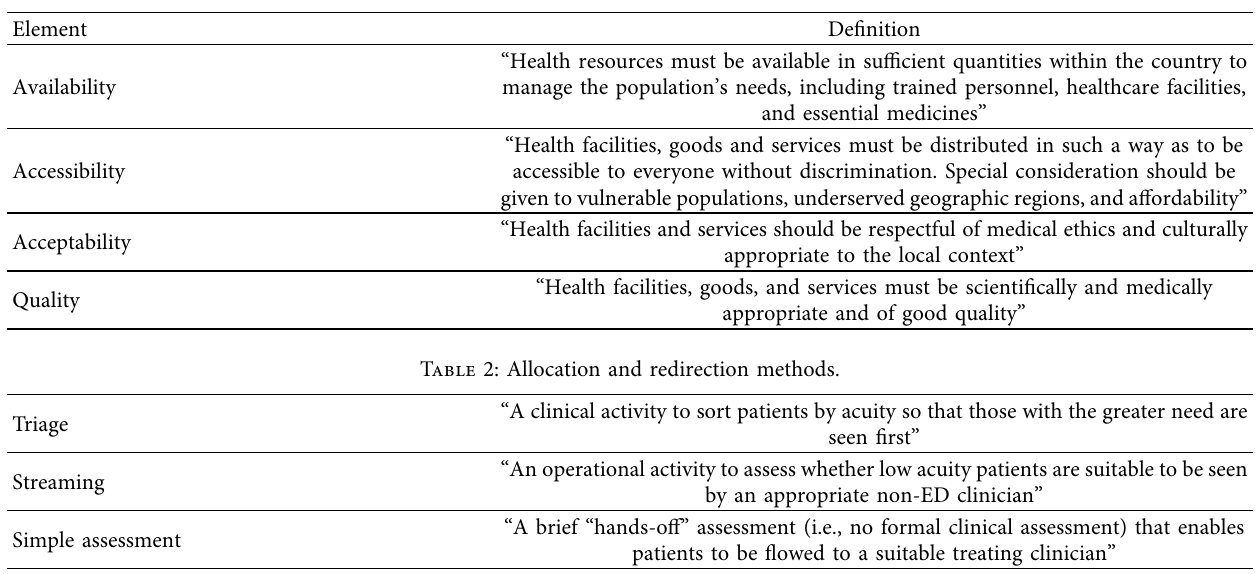
Table 1: Essential elements of the right to health.